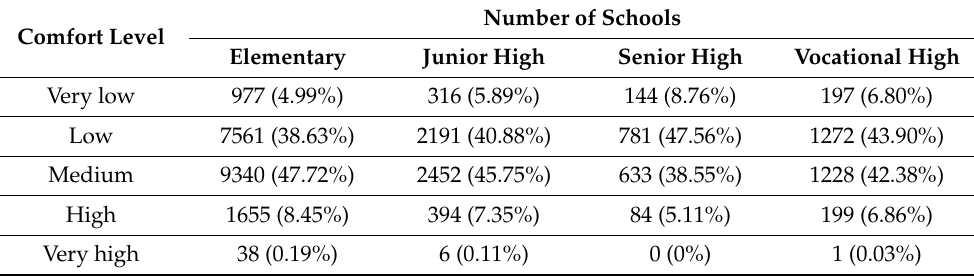
Table 4. The number of schools at each comfort